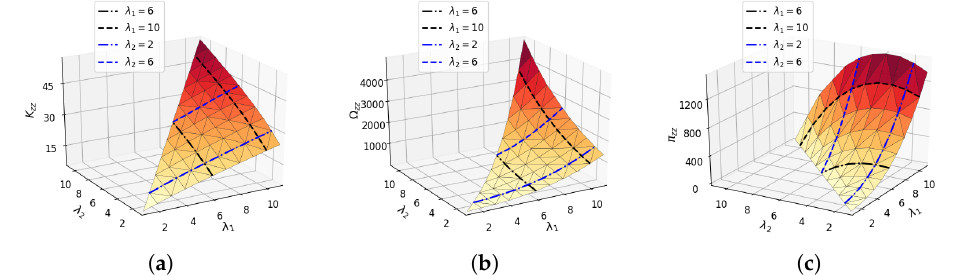
Figure 6. Tensor component values are presented with respect to λ 1 and λ 2 , for the examples of tensor components K zz , Ω zz and Π zz , shown at ( a – c ) sections respectively. Parameters e 1 and e 2 are fixed to unity. Note the triangular shape of the plot surface, due to the imposed limitation λ 2 ≤ λ 1 . Black and blue dotted lines are displaying the one-dimensional fit functions, which are positioned at the fixed values of λ 1 and λ 2 as indicated in the plot legend.